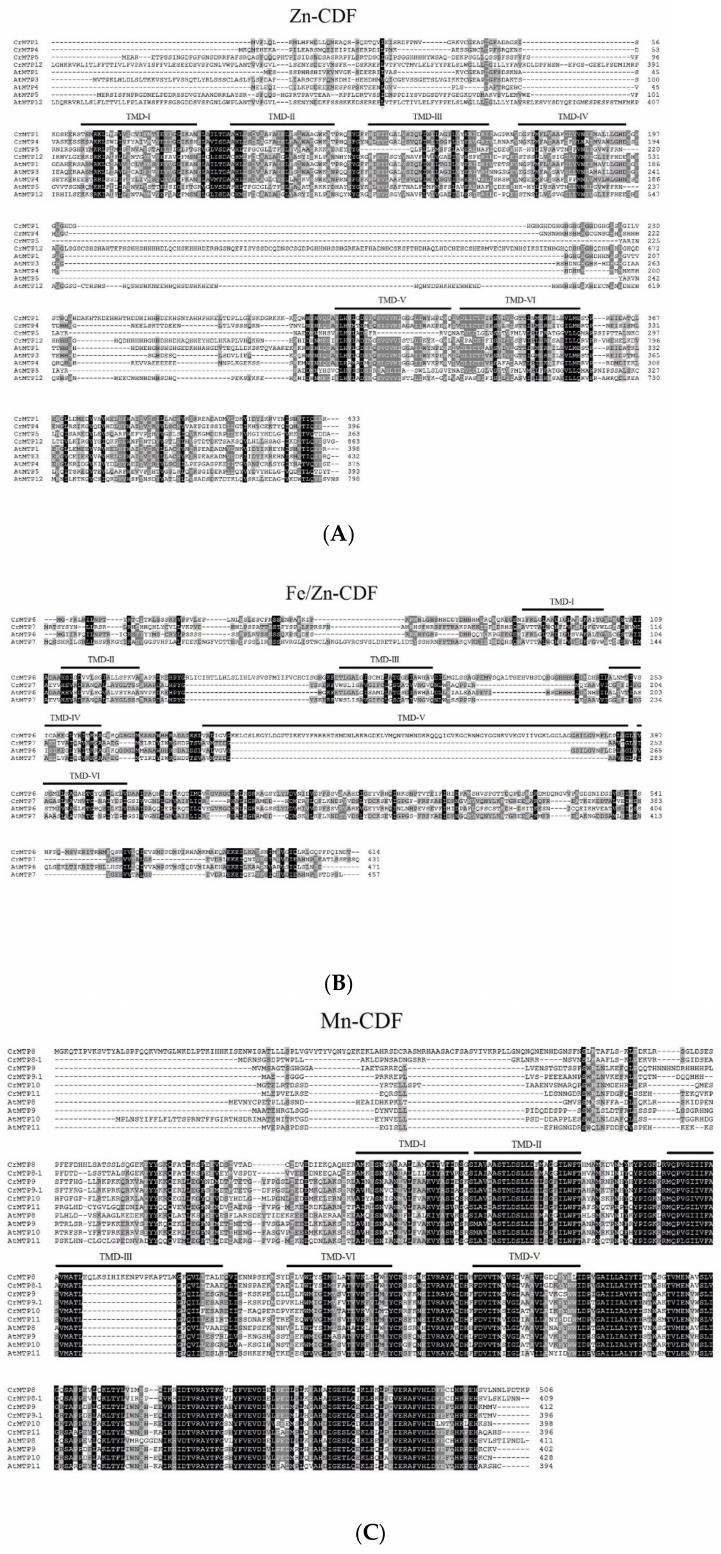
Figure 1. Multiple sequence alignment of CrMTP and AtMTP proteins. A total of 12 CrMTP proteins were identified in Canavalia rosea (Sw.) DC. and AtMTP proteins from Arabidopsis thaliana were classified into Zn-CDFs ( A ), Fe/Zn-CDFs ( B ), and Mn-CDFs ( C ) and then aligned using ClustalW. The transmembrane domains (TMDs I–VI) were marked with bold